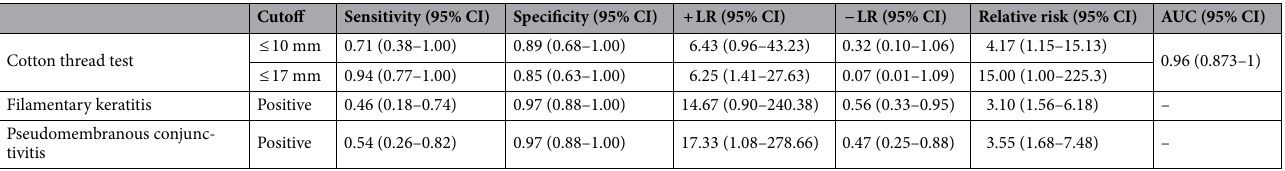
Table 3. Performance of diagnostic factors for DED related to graft-versus-host disease in pediatric patients. DED dry eye disease; + LR positive likelihood ratio; − LR negative likelihood ratio; AUC area under the receiver operating characteristic